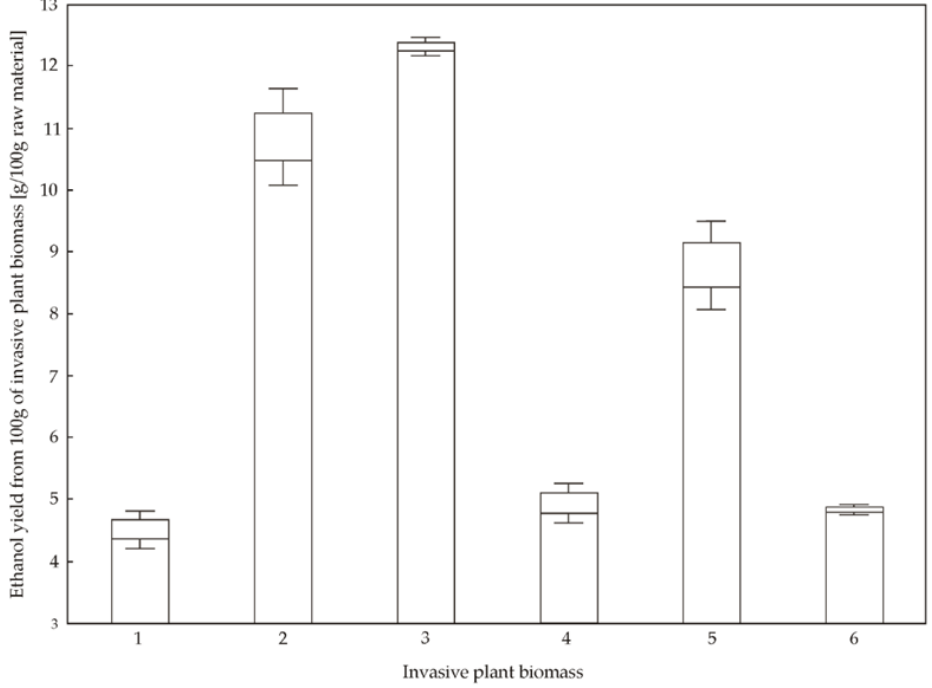
Figure 3. Ethanol yield from 100 g of invasive plant species biomass, where: 1 — Reynoutria japonica ; 2 — Reynoutria sachalinensis ; 3 — Reynoutria × bohemica; 4 — Solidago Canadensis ; 5 — Solidago gigantea ; 6 — Spiraea tomentosa . Mean, mean ± standard error — box, mean ± 1.96 standard error — whiskers.